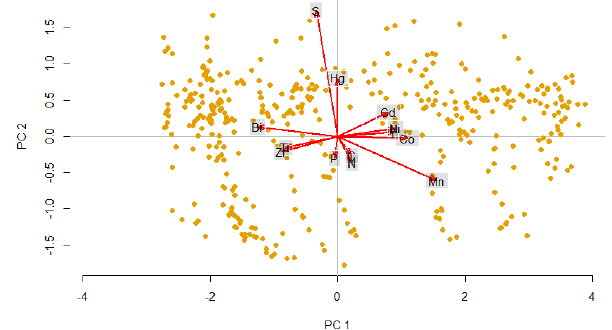
Figure 3. Biplot for robust compositional PCA of 54 elements in sediments deposited after the year 1960. A total of 13 elements with the strongest loadings are shown by arrows.